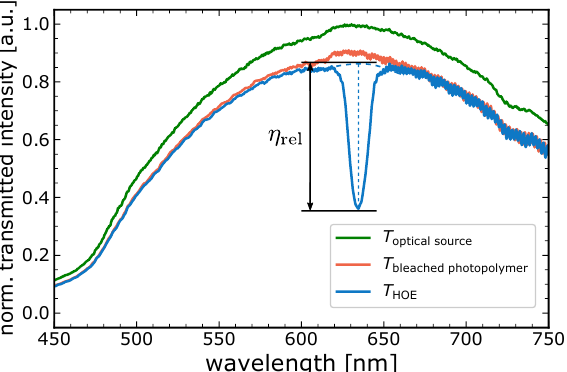
Figure 4. Normalized transmission spectrum of the employed optical source, a bleached photopoly- mer film and a recorded vHOE. The relative diffraction efficiency η rel of the vHOE is determined from the vHOE’s chromatic selectivity, normalized to the bleached photopolymer film transmission